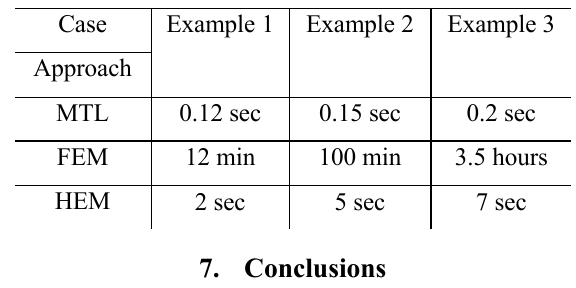
Table 3: Computation time at each frequency through the MTL, FEM, and HEM for the three